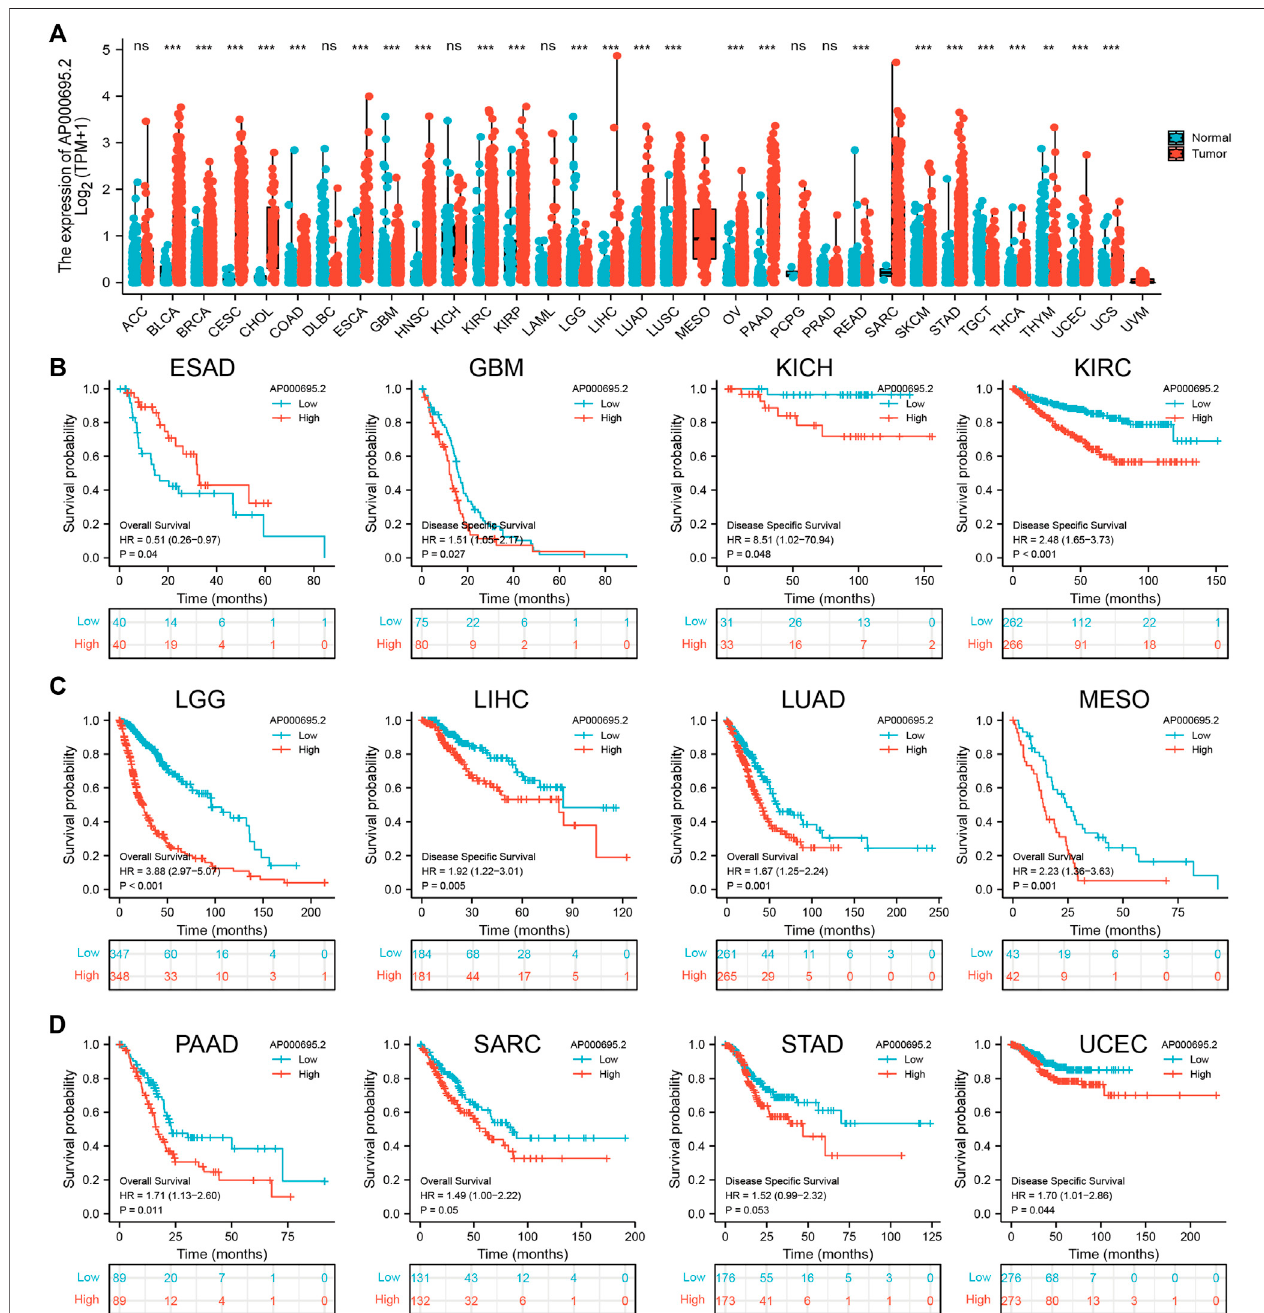
FIGURE1| ExpressionlevelandprognosisoflncRNA-AP000695.2inhumancancer. (A) ExpressionoflncRNA-AP000695.2innormalandtumortissuesinTCGA and GTExdata,basedon thebest cutoffscoretodistinguish high- and low-expressiongroups. (B – D) Correlation betweenAP000695.2expression and cancer survival prognosis. * p < 0.05, ** p < 0.01, and *** p < 0.001.